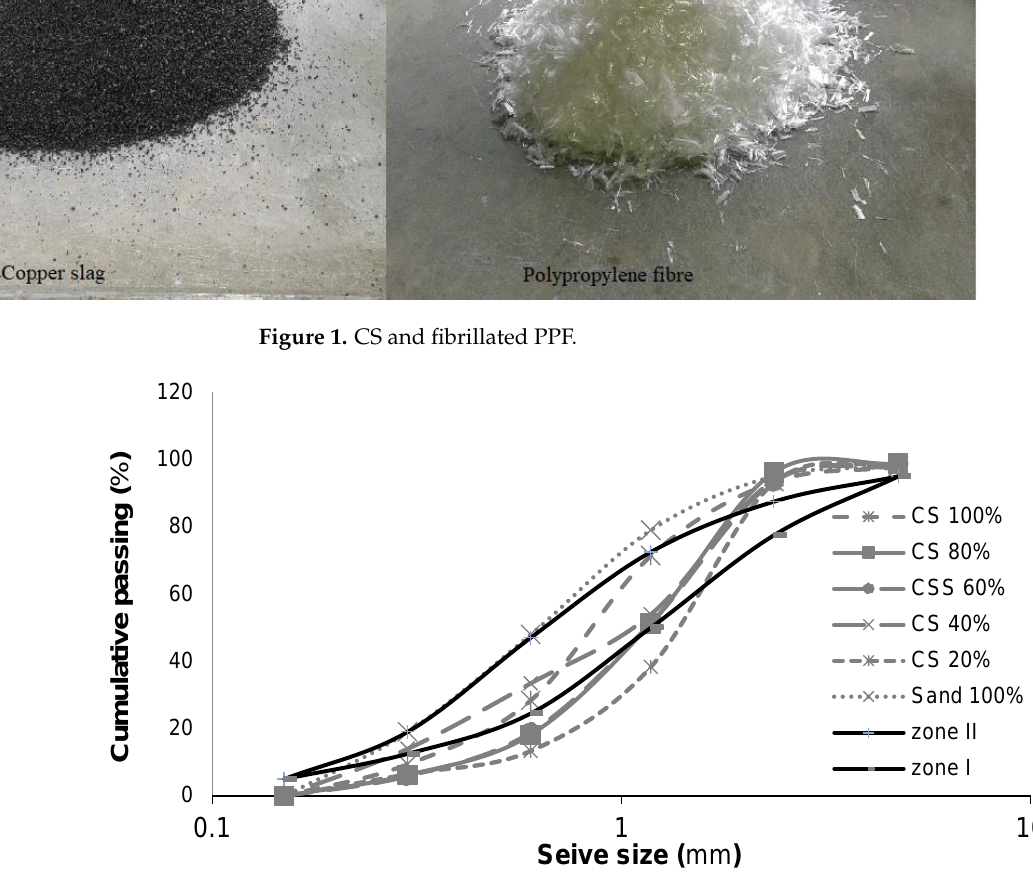
Figure 2. Particle size distribution of fine aggregates. Table 2. Chemical composition of cement and copper slag.